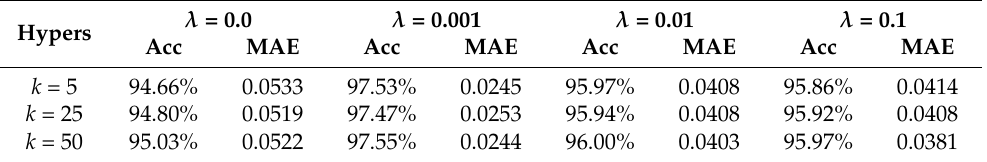
Table 2. The mean Acc and MAE of VISOR-NET under different hyper parameters with the ExFRIDA